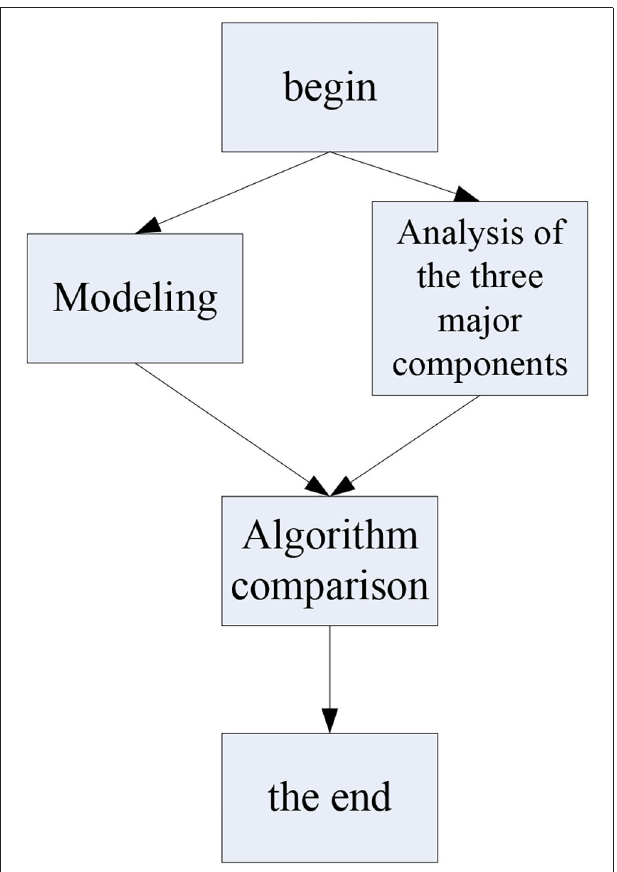
FIGURE 3 | Experimental flowchart.